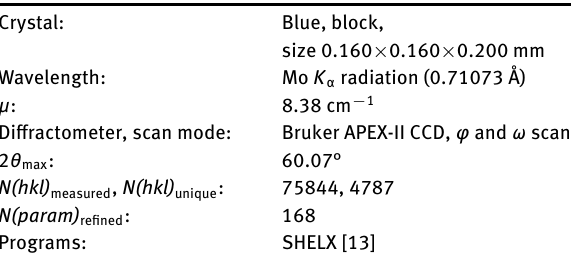
Table 2: Fractional atomic coordinates and isotropic or